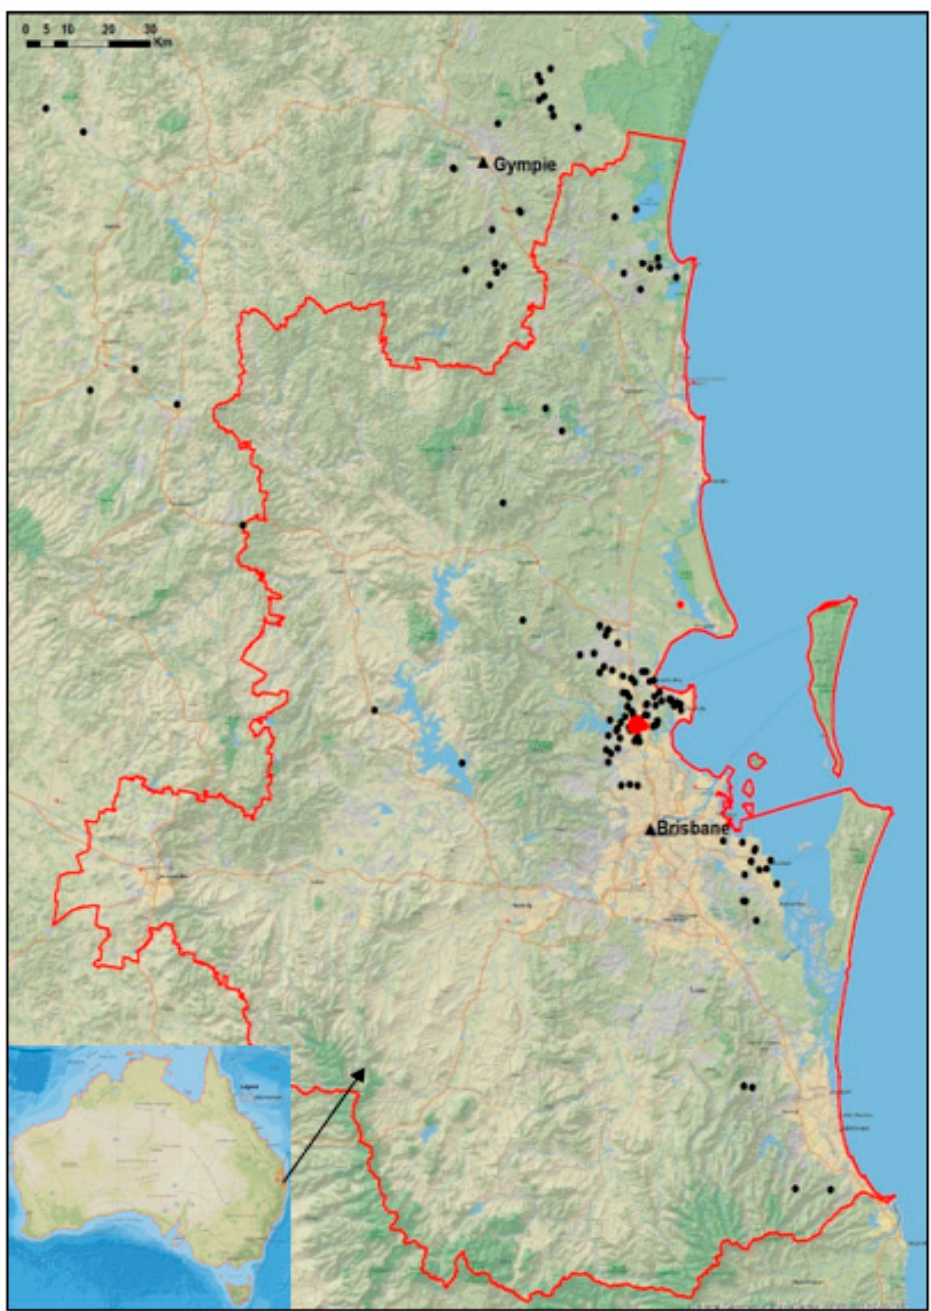
Figure 1. Map of South East Queensland (SEQ; red line) showing the provenance of the koalas admitted to the Australia Zoo Wildlife Hospital (black circles), and the location of the 88 The Mill koalas (red circles). The inserted map shows the location of South East Queensland in Queensland, Australia.